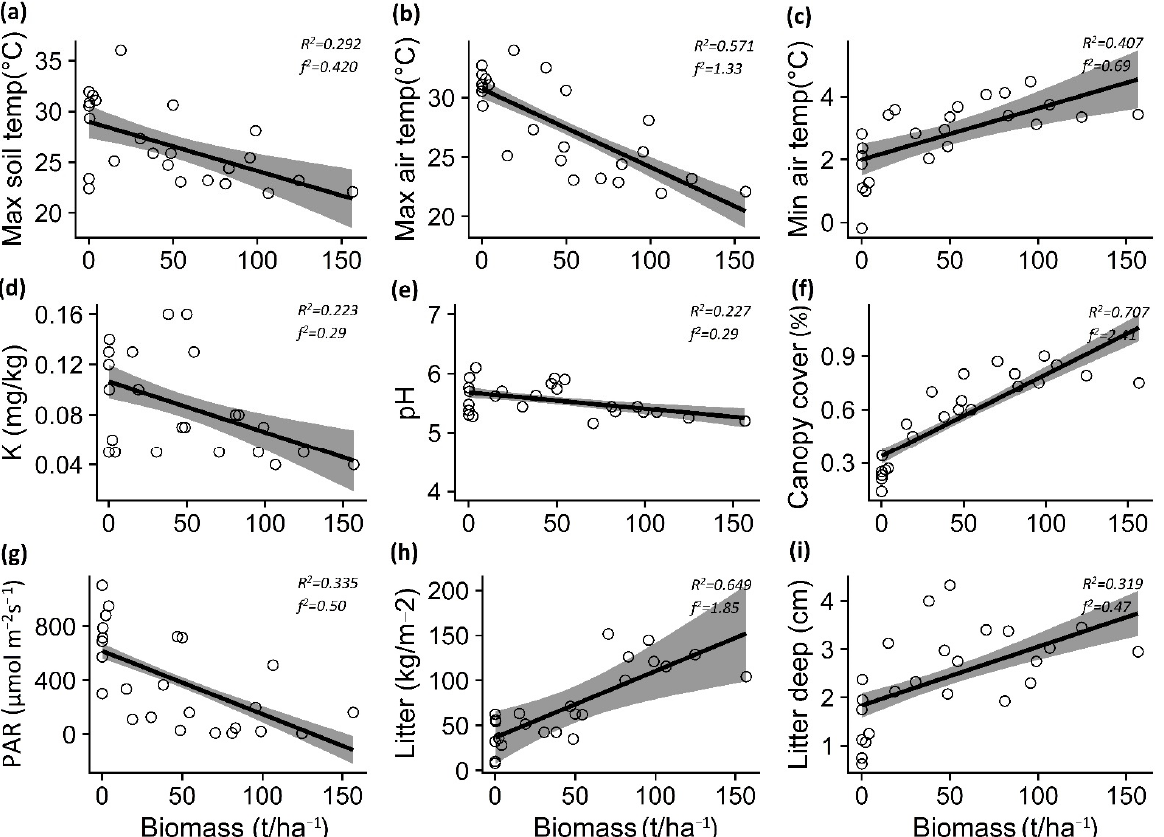
Figure 3. Relationship between Pinus contorta biomass and maximum soil and air temperatures ( a , b ), minimum air temperature ( c ), potassium ( d ), pH ( e ), canopy cover ( f ), PAR light ( g ), total litter ( h ), and litter depth ( i ) for Araucaria araucana forest. The lines show the linear model fit and the 95% confidence interval. R 2 is the adjusted R 2 .